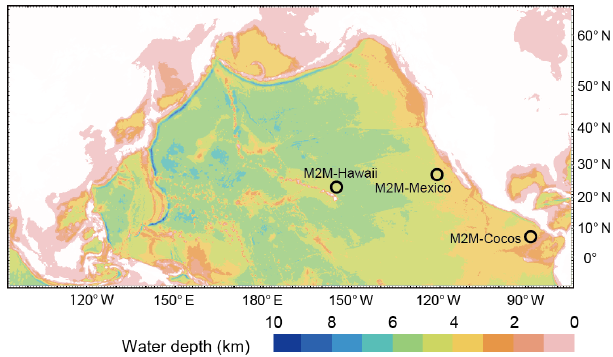
Figure 2. Bathymetric map of the Pacific Ocean showing candidate sites for the Moho to Mantle (M2M) drilling